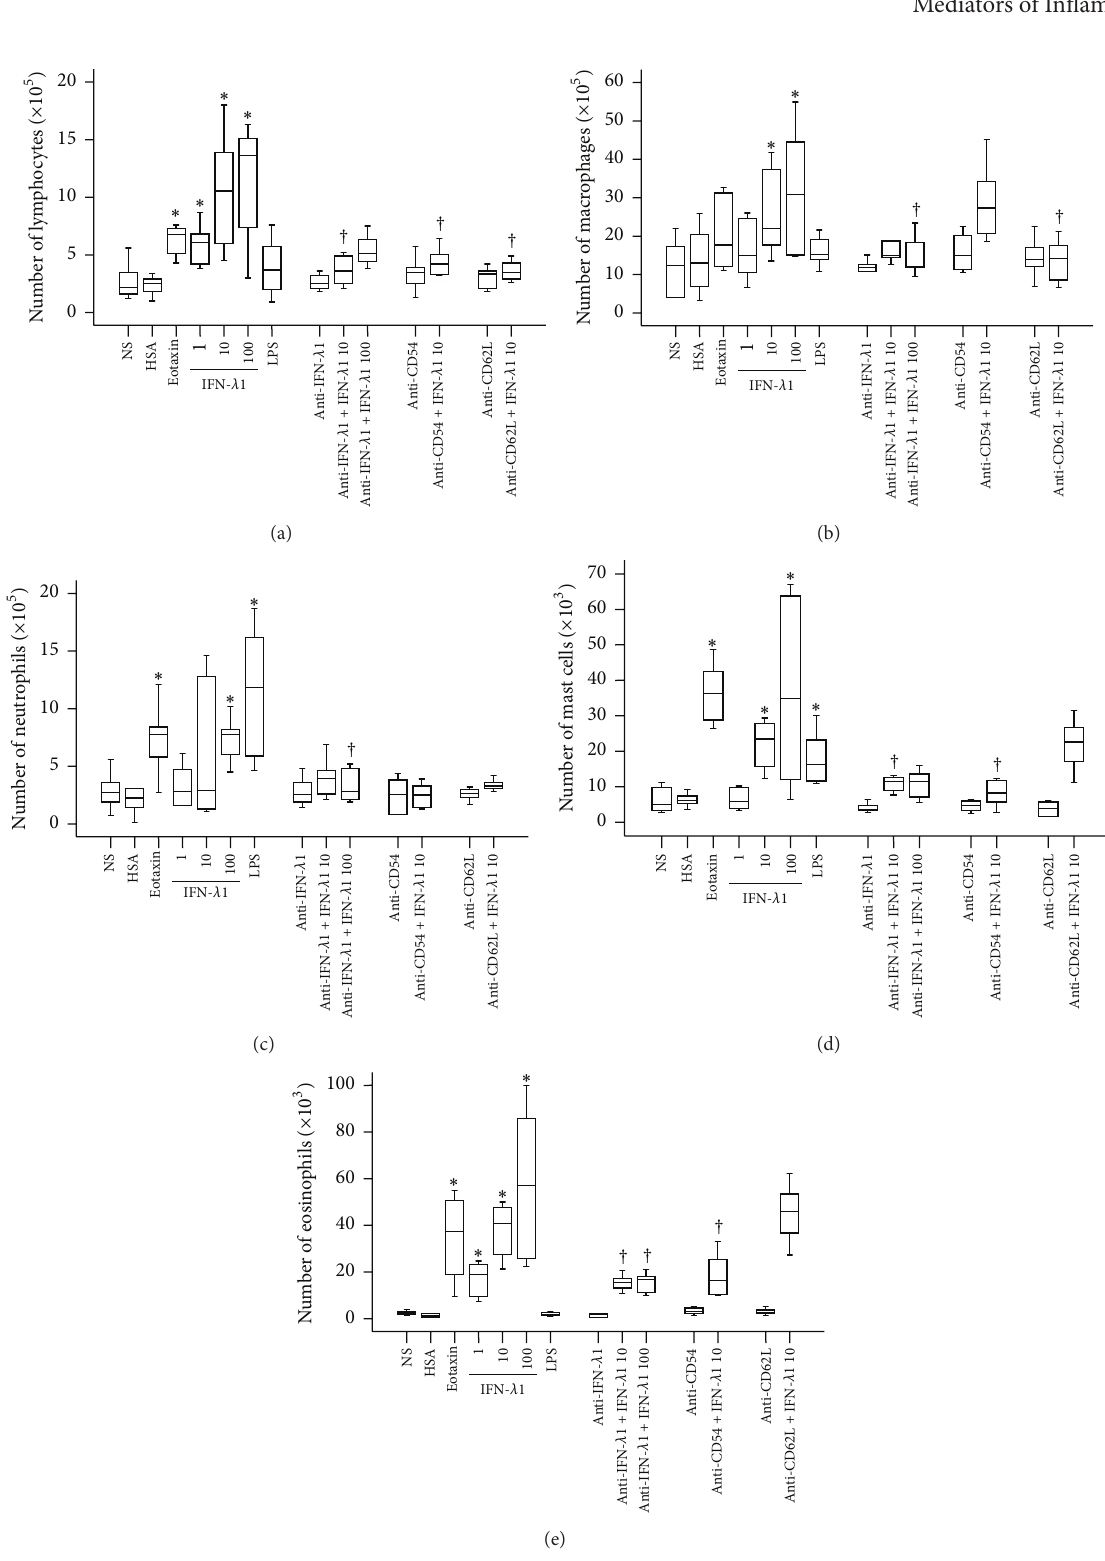
Figure 6: Interferon- (IFN-) 𝜆 1 induces inflammatory cell accumulation in mouse peritoneum. Mice were treated with IFN- 𝜆 1 (ng/mL) in the presence or absence of its specific antibody (3.0 𝜇 g/mL), eotaxin (10ng/mL), human serum albumin (HSA, 10 ng/mL), lipopolysaccharide (LPS, 1.0 𝜇 g/mL), and normal saline (NS) for 6 h before their peritoneal lavage being collected for differential cell analysis. For certain mice, anti-CD54 antibody (anti-CD54, 1 mg ⋅ kg −1 ) and anti-CD62L antibody (anti-CD62L, 1mg ⋅ kg −1 ) were injected via tail vein 30 min before IFN- 𝜆 1 being injected. Data were displayed as a boxplot, which indicates the median, interquartile range, the largest, and smallest values other than outliers (whiskers) and the outliers (O). Each piece of data represented a group of 6-7 animals. ∗ 𝑃 < 0.05 compared with the corresponding NS group. † 𝑃 < 0.05 compared with the corresponding stimulus alone